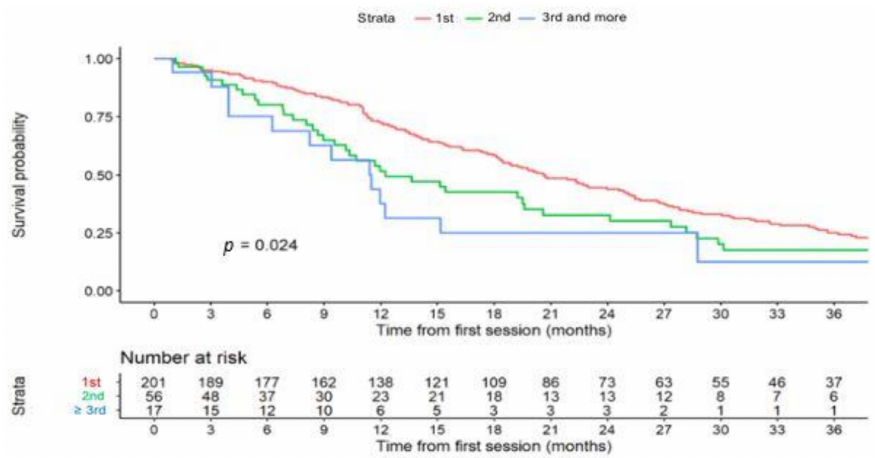
Figure 2. Time to liver progression (TT L P) curves according to the number of transarterial chemoem- bolization (TACE) cycles.